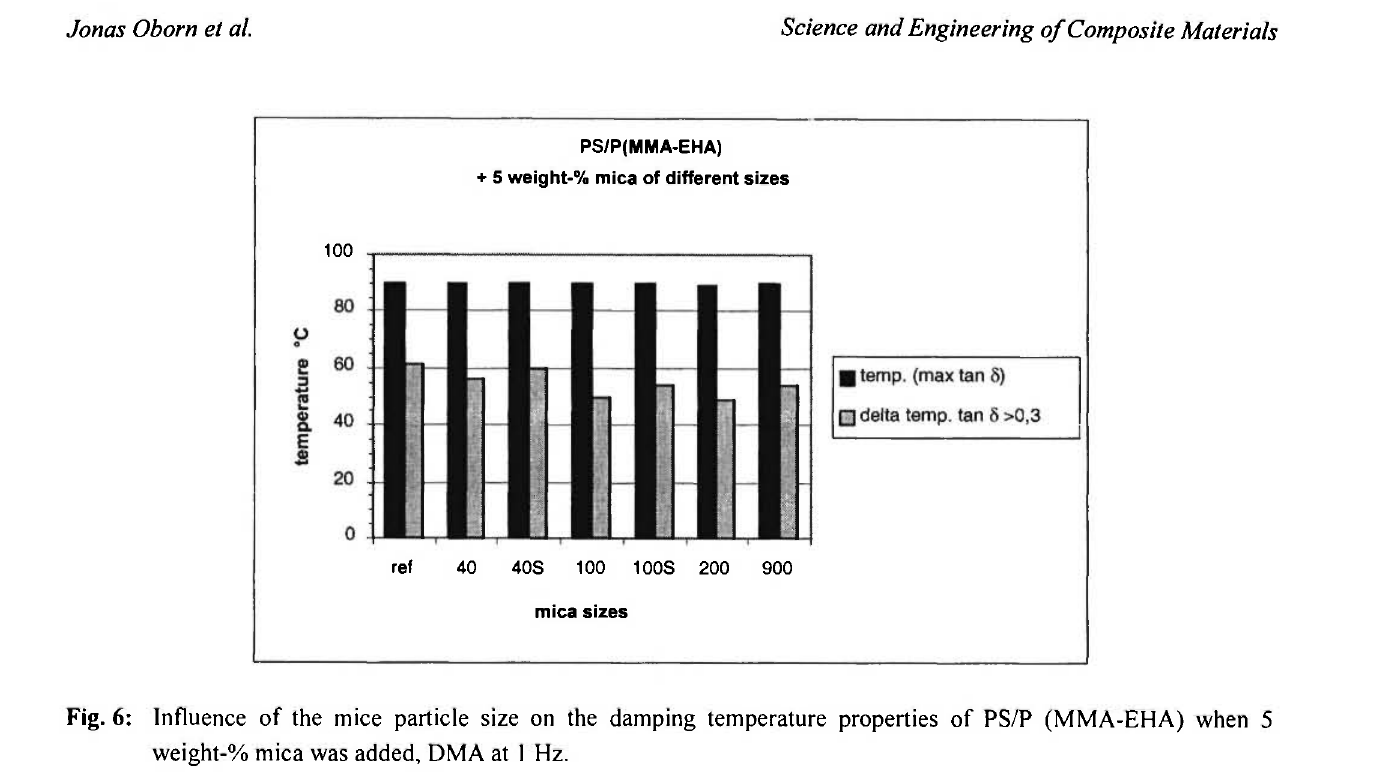
Fig. 6: Influence of the mice particle size on the damping temperature properties of PS/P (MMA-EHA) when 5 weight-% mica was added, DMA at 1